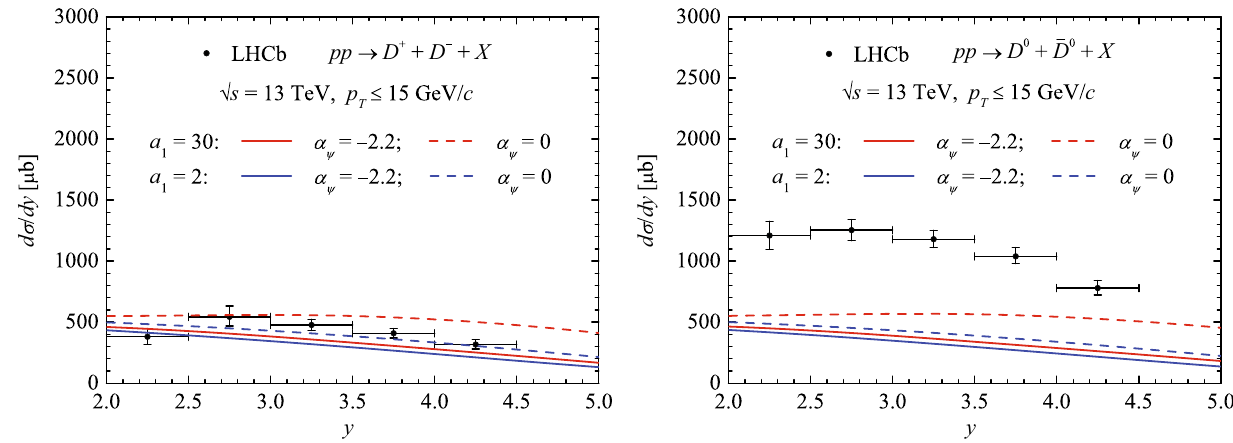
Fig. 10 Differential cross sections of charged D mesons (left) and neutral D mesons (right) in pp collisions at LHCb experiment [52]. The same notation for lines as in Fig. 9